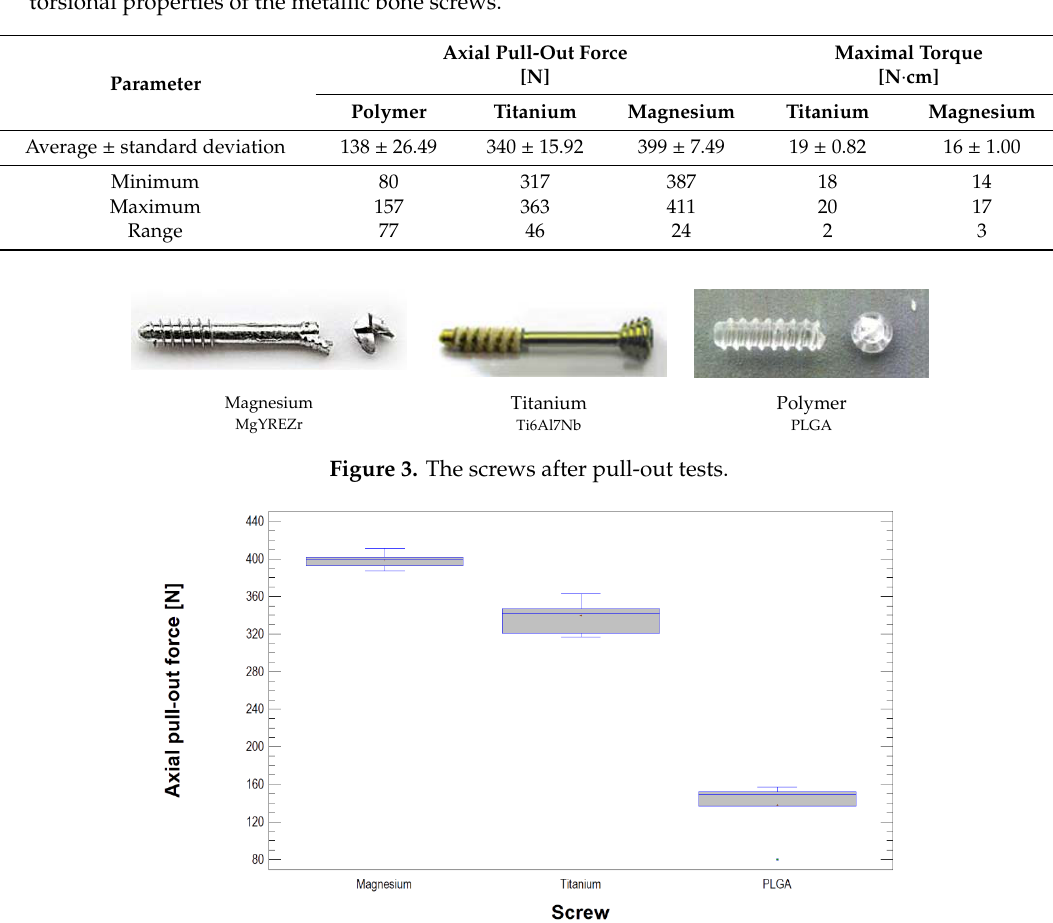
Figure 4. Summary statistics for axial pull-out force [N]. There were significant differences among the three types of screws ( p < 0.05). Magnesium alloy screws show the greatest strength.